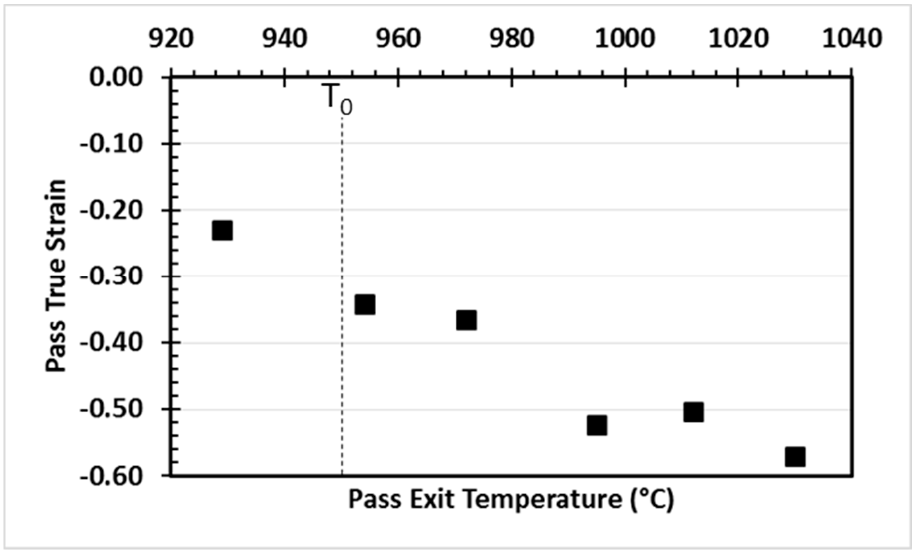
Figure 1. Strain–temperature profile used for finish rolling of the sample plate used in the present investigation. T 0 = 950 °C is the ferrite to asutenite transformation temperature measured by dilatometry during heating at 0.25 °C/s.